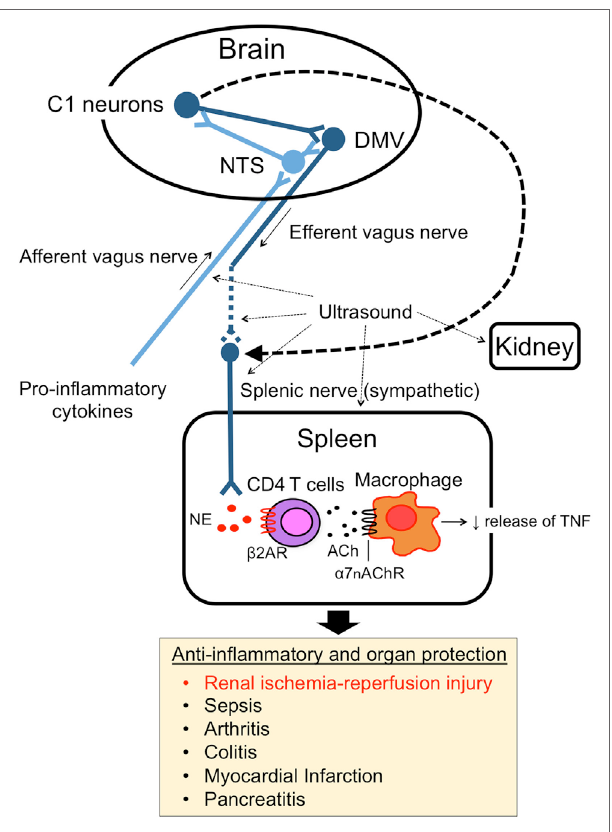
FiGURe 1 | Cholinergic anti-inflammatory pathway (CAP). The CAP links the nervous system and immune system. The activity of afferent vagus nerve fibers is stimulated by cytokines and pathogen-associated molecular pattern molecules. The signal activates efferent vagus nerve fibers through the nucleus tractus solitarius (NTS) and dorsal motor nucleus of the vagus in the brain. The efferent vagus nerve (cholinergic) stimulates CD4 T cells in spleen via the splenic sympathetic (adrenergic) nerve. Release of norepinephrine binds to β 2-adrenergic receptors ( β 2ARs) on CD4 T cells, which then elicits release of acetylcholine (ACh). ACh binding to alpha 7 nicotinic acetylcholine receptors ( α 7nAChRs) on macrophages produces an anti-inflammatory response, such as TNF- α suppression. Ultrasound and C1 neuron stimulation also activate the pathway and produce organ protective effects.